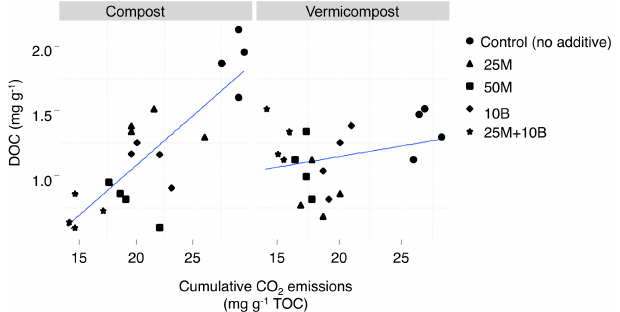
Figure 5. Comparison between total CO 2 emissions (composting + incubation with soil) and dissolved organic carbon (DOC) in the amendments. Key as in previous figures. Table 3. CO 2 emissions during the experiments. C: compost; V: vermicompost; B: biochar; M: clay. Data with different small letters indicate significant differences between